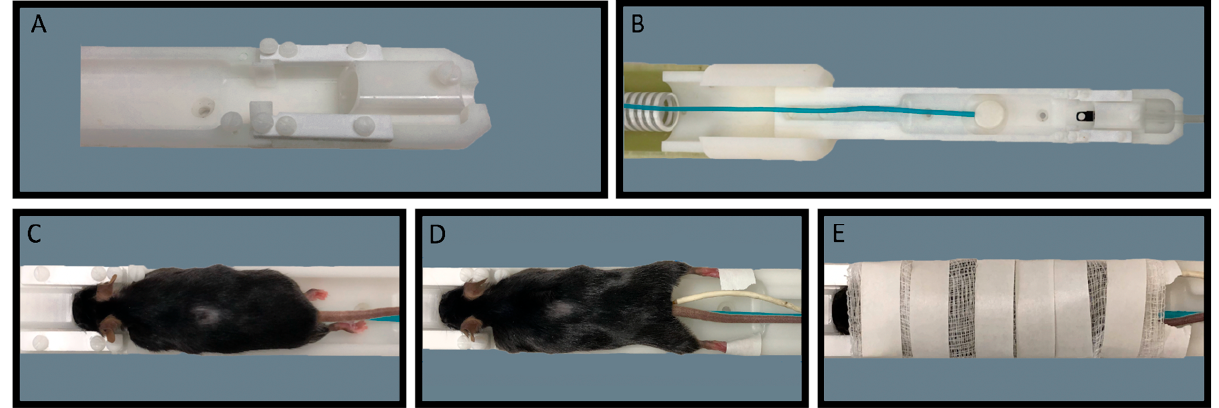
Figure 1. Awake Animal Imaging Holder. A custom mouse holder with nose cone and head brace ( A ), and mouse holder with tooth bar, respiration monitor, and heat source ( B ). Image of mouse placed in holder, with nose in nose cone and on tooth bar ( C ). Image of mouse with limbs taped down and temperature probe inserted ( D ). Image of mouse fully secured with gauze and tape to reduce all movement during imaging ( E ). Oxygen was supplied to the subjects through the oxygen hose during imaging and acclimation.